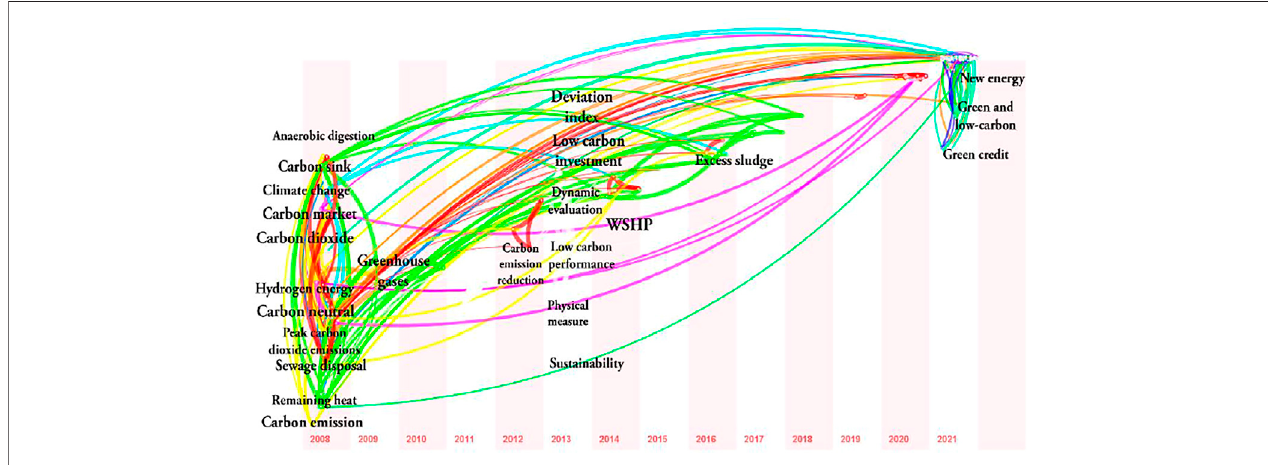
FIGURE 8 | Keyword timing